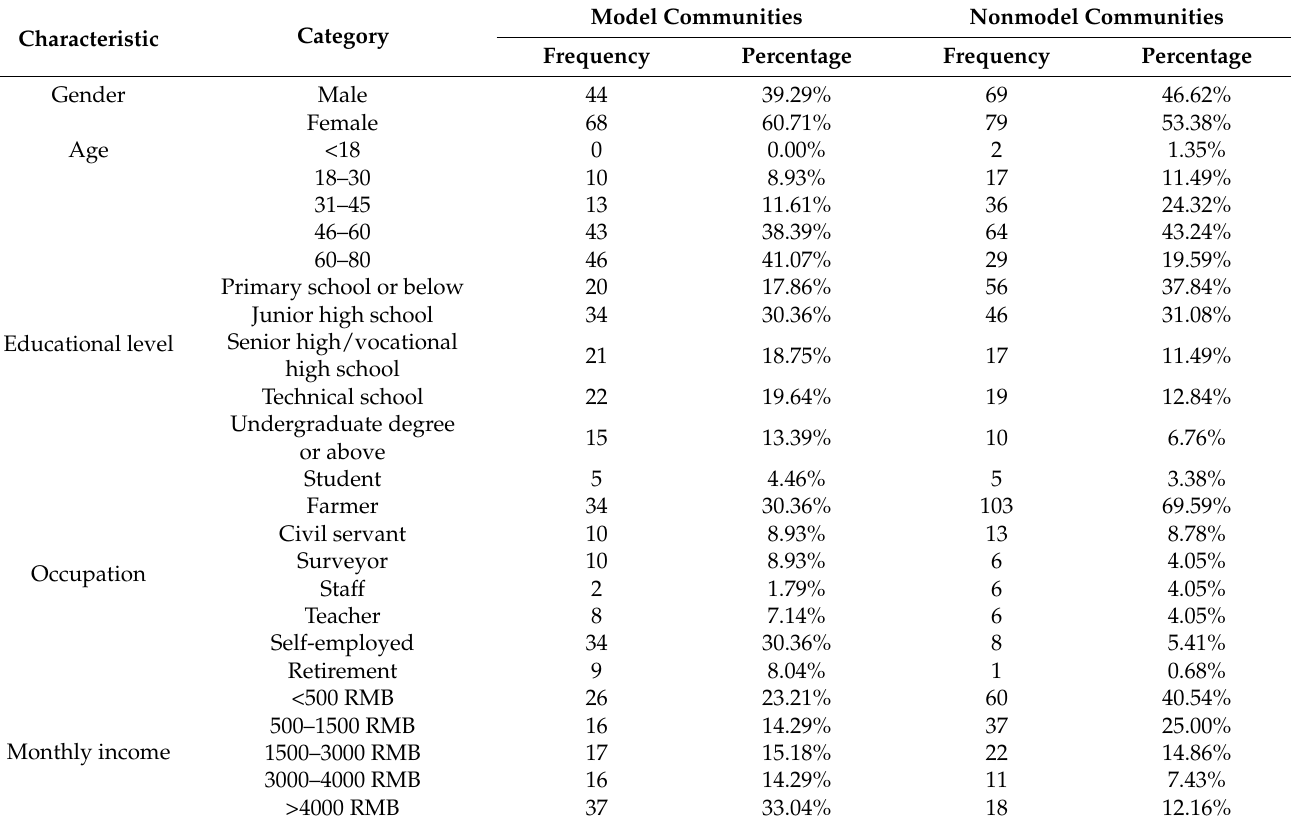
Table 1. Demographic characteristics of the